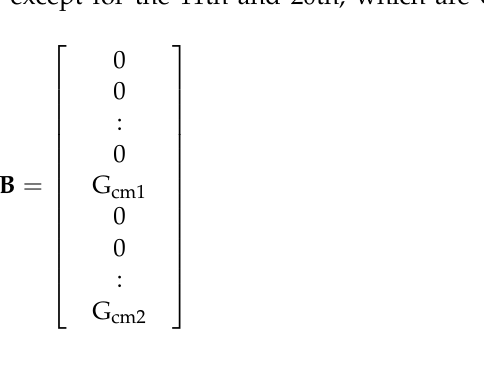
Table 1. Connection matrix A for ‘Type 1’ front-end